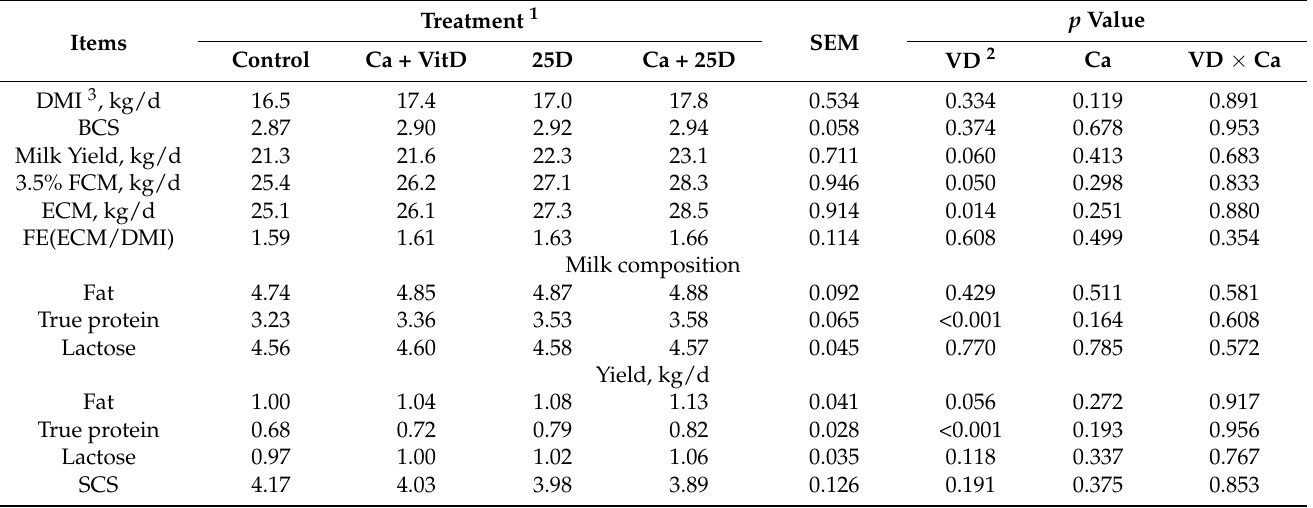
Table 2. Effect of 25-hydroxyvitamin D 3 and oral calcium bolus on lactation performance of postpartum Holstein cows.